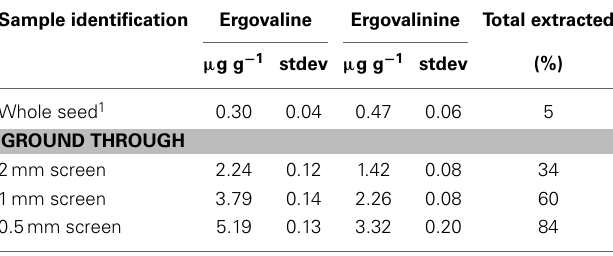
Table 1 | Seed particle size and extraction efficiency with 80% aqueous ethanol.